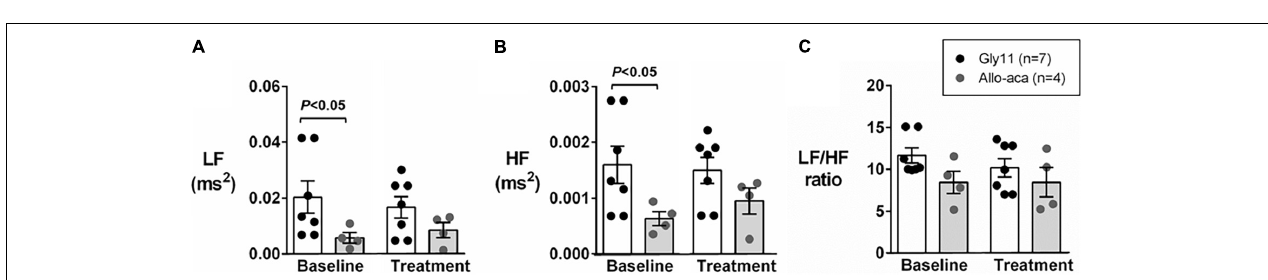
FIGURE 3 | Leptin receptor blocker Allo-aca did not affect sympathetic and parasympathetic activities, and cardiac autonomic balance. (A) Low frequency (LF) and (B) high frequency (HF) components of heart rate were lower at baseline in Allo-aca group, but no significant effects of the treatment were observed. (C) LF/HF ratio was similar between groups and compared to baseline. Mean values ± standard errors are shown. Mann–Whitney U test and Wilcoxon signed-rank test.